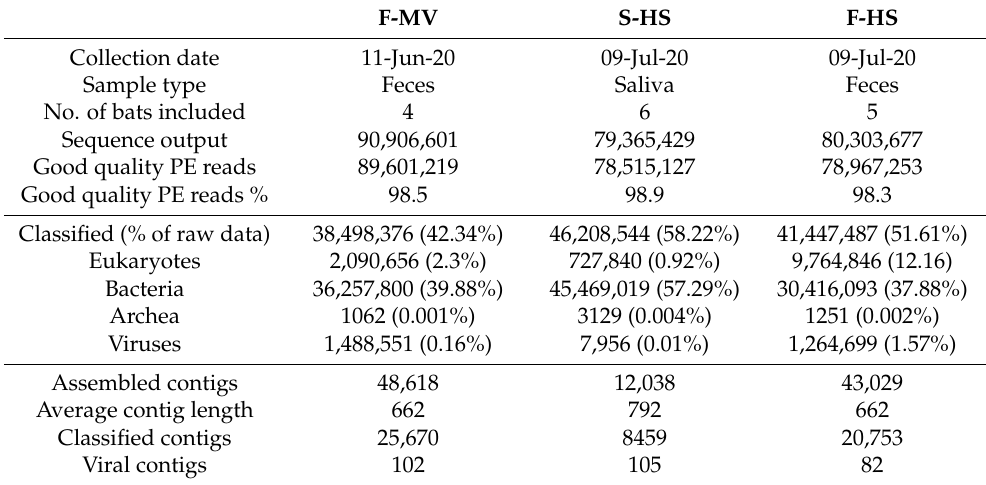
Table 1. Summary of Pipistrellus pygmaeus bat samples analyzed in this study, taxonomic classification of reads and assembly of the